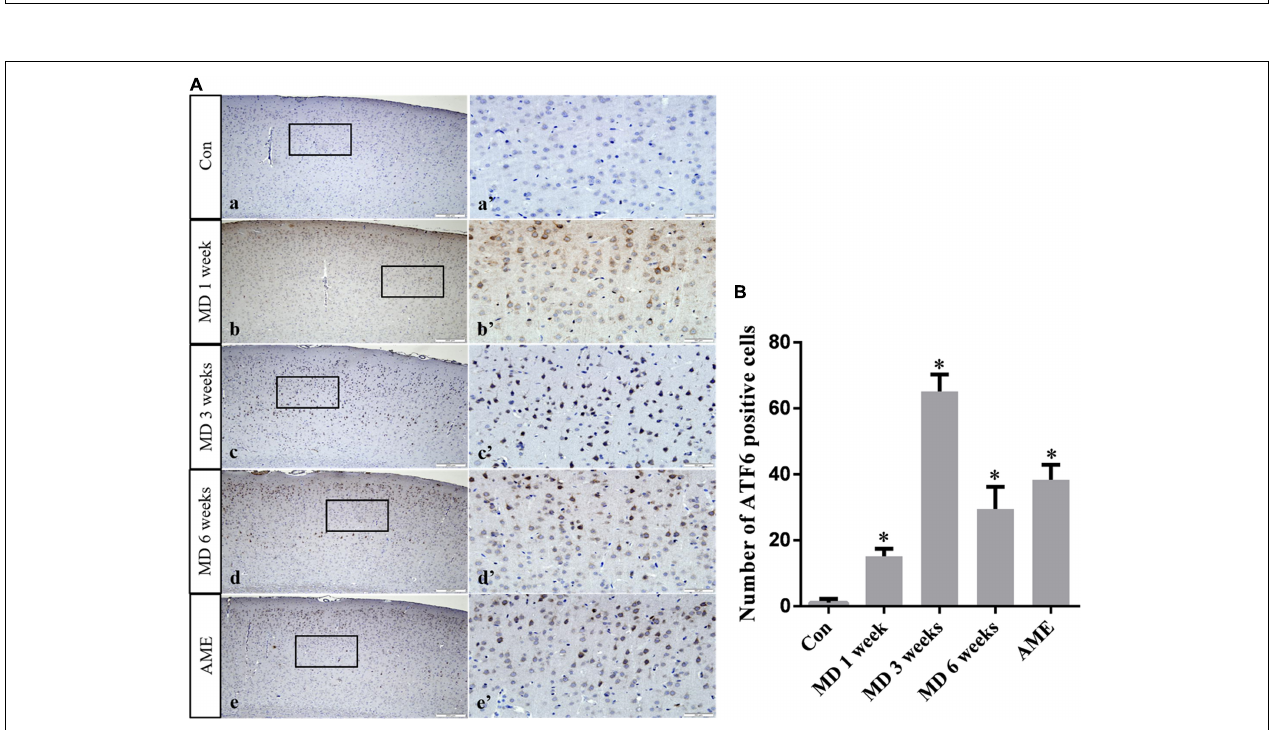
FIGURE 6 | (A) Representative images showing CHOP immunohistochemistry in the cortex. Panels (a’–e’) are magnified areas of panels (a–e) . Bars = 200 µ m in panels (a–e) . Bars = 50 µ m panels in (a’–e’) . (B) Quantitative analysis of the number of CHOP positive cells. The data are shown as mean ± SD, ∗ P < 0.05 vs. control group ( n = 6). MD, morphine dependence; AME, acute morphine exposure.